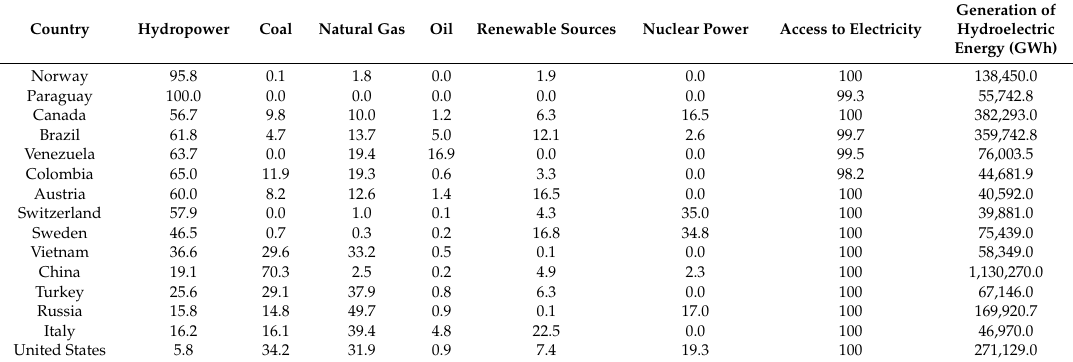
Table A1. Sources of electricity production (% of total) and generation of hydroelectric energy (GWh), 2015.